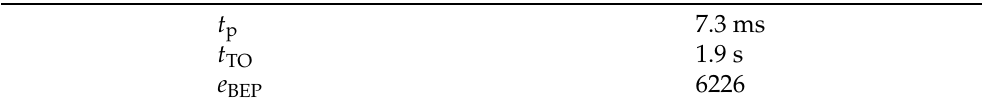
Table 5. Time comparison of conventional and predictor–evaluator network (PEN) based methods at a resolution of 64 ×